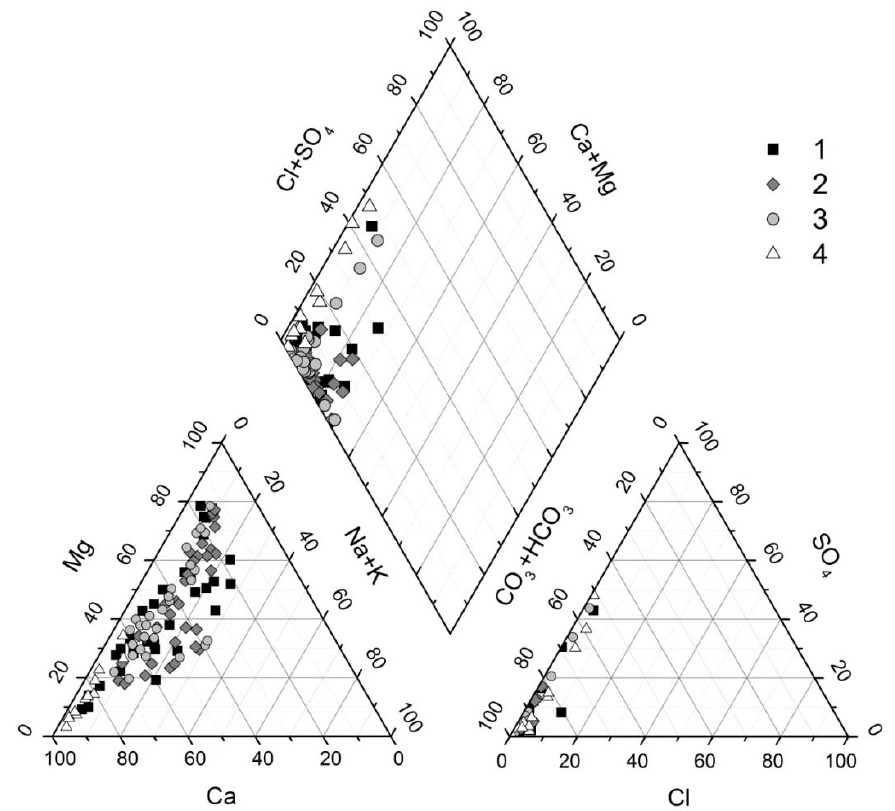
Figure 5. Piper diagram showing anion and cation compositions of the studied waters. 1—waters of active layer; 2—lakes; 3—rivers; 4—waters of stone pits and exploration trenches.